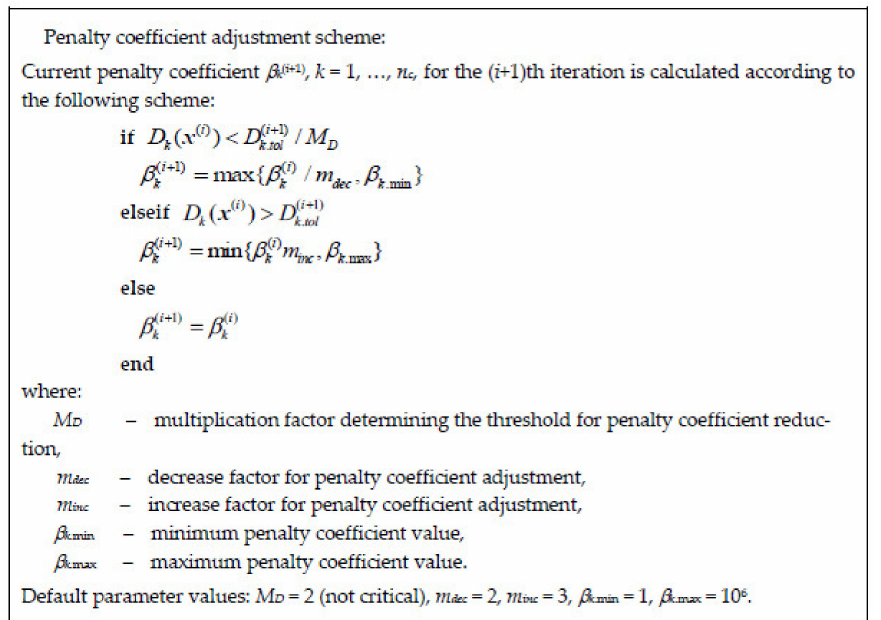
Figure 2. Penalty coefficient setup according to the methodology of